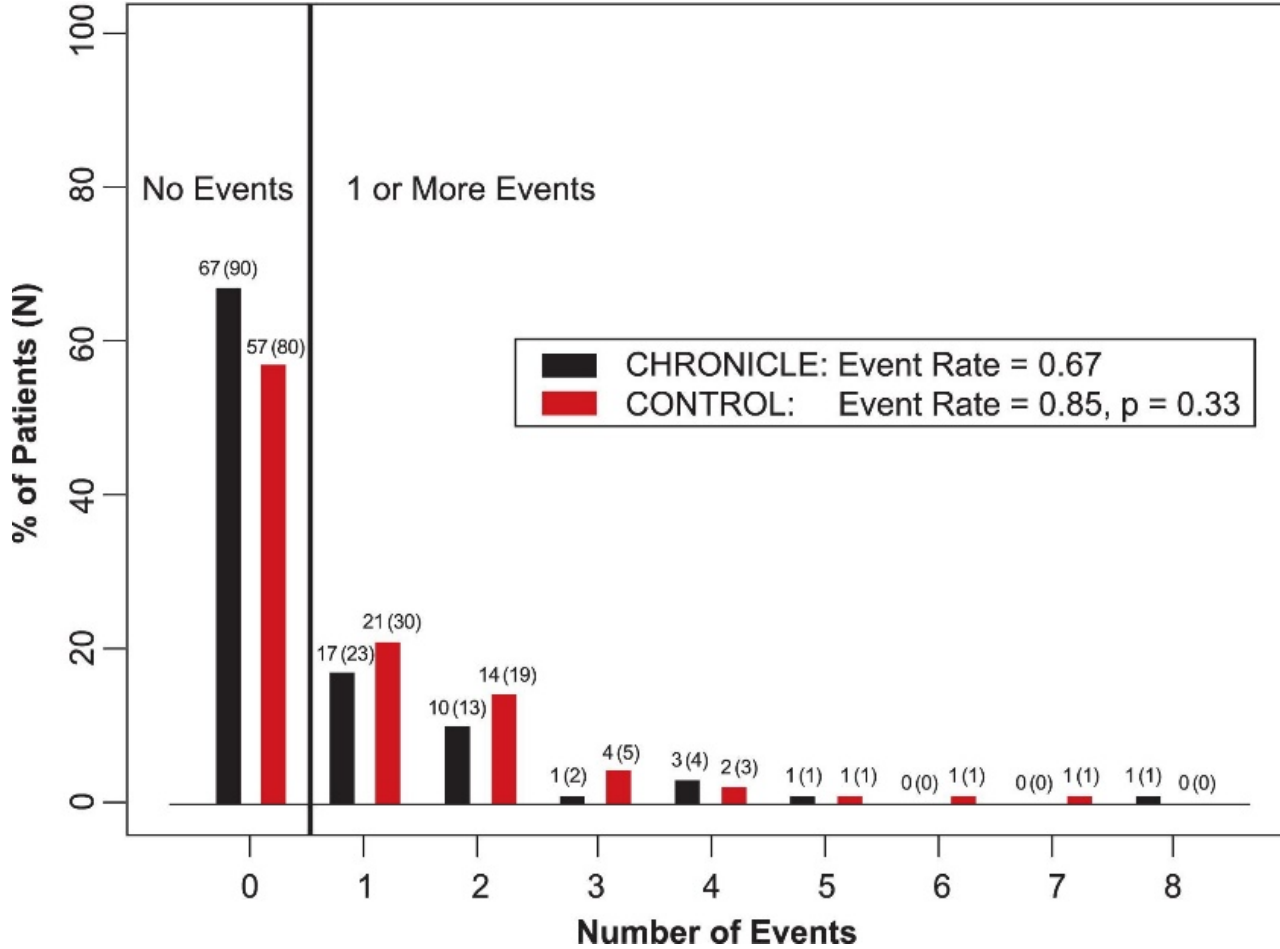
Figure 5. Rates of heart failure-related events as reported in the Chronicle Offers Management to Patients with Advanced Signs and Symptoms of Heart Failure (COMPASS-HF) study. Reprinted from Journal of the American College of Cardiology, Volume 51, Issue 11, Bourge et al., Randomized Controlled Trial of an Implantable Continuous Hemodynamic Monitor in Patients with Advanced Heart Failure, the COMPASS-HF Study, Pages 1073–1079, Copyright 2008, with permission from Elsevier [19].